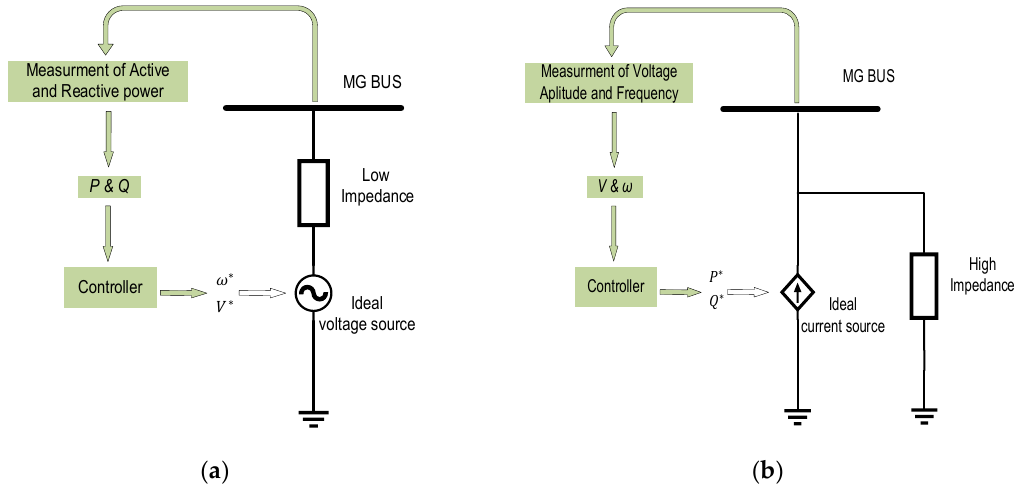
Figure 6. Representation of different modes of inverters in microgrids. ( a ), grid forming/grid supporting VSI, ( b ), grid feeding/grid supporting CSI.